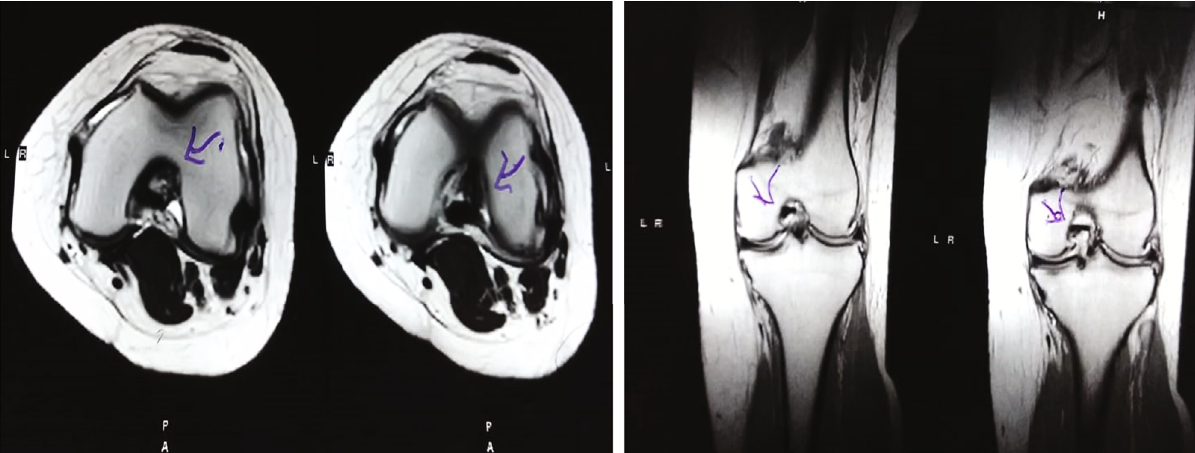
Figure 2: Posttreatment MRI showing improvement in the tear in the posterior horn of the medial and lateral menisci. The patient experienced symptomatic improvement as well as enhanced ability to perform her activities of daily